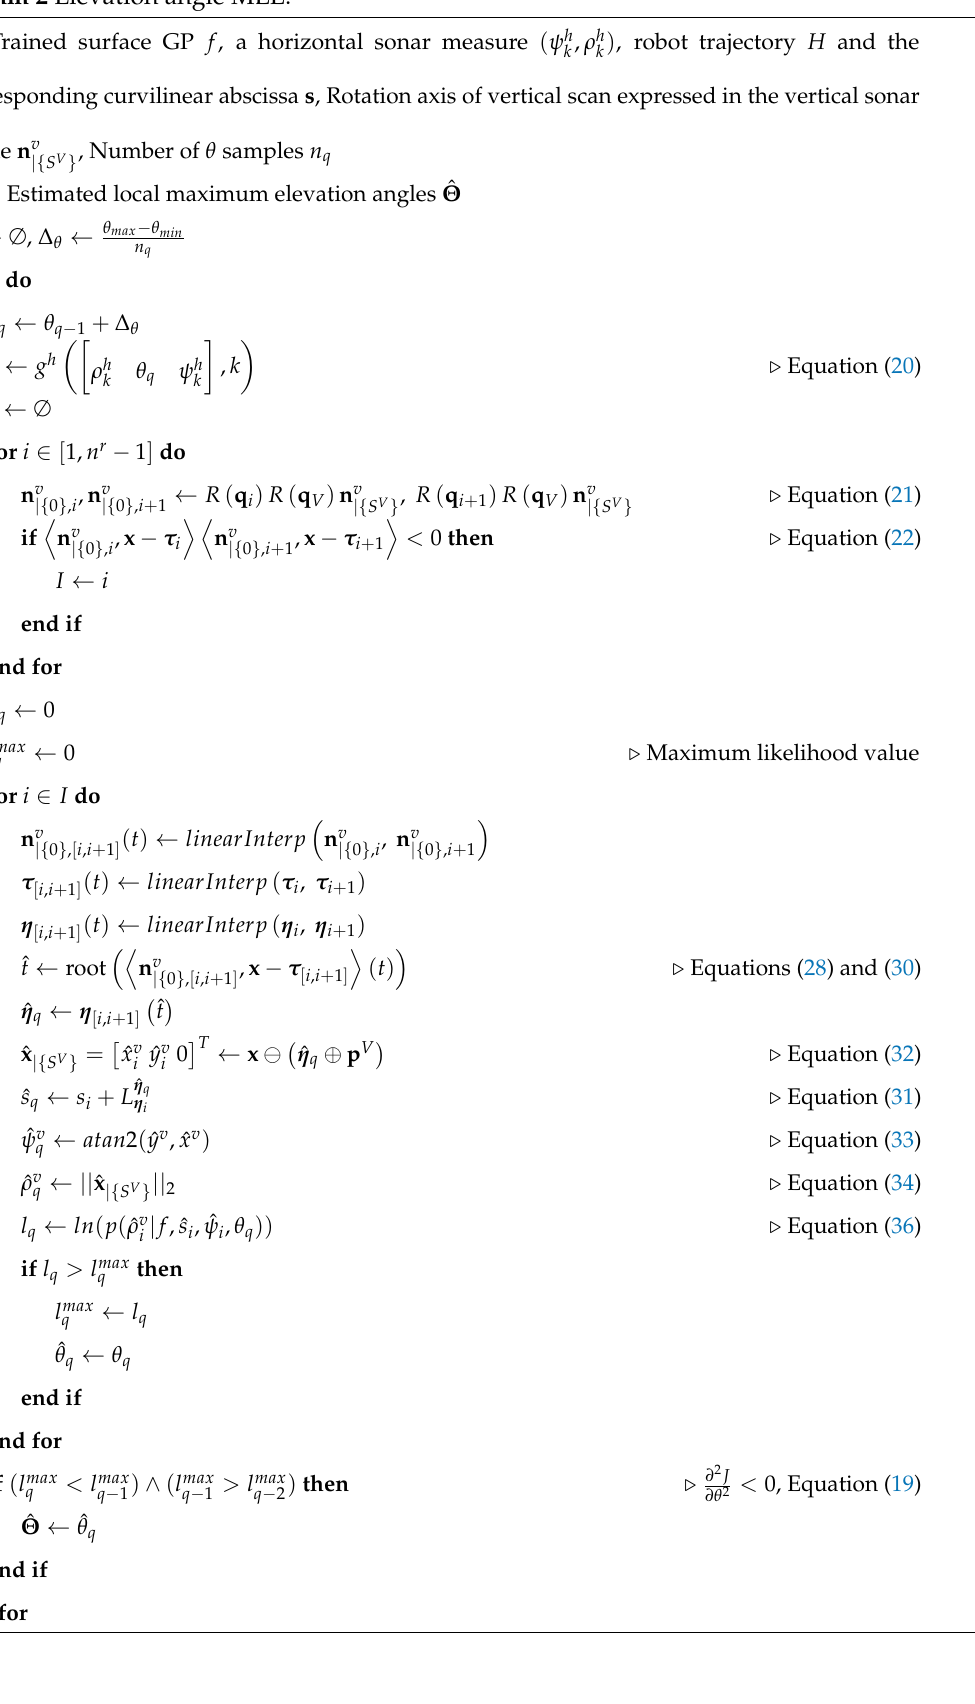
Algorithm 2 Elevation angle MLE.